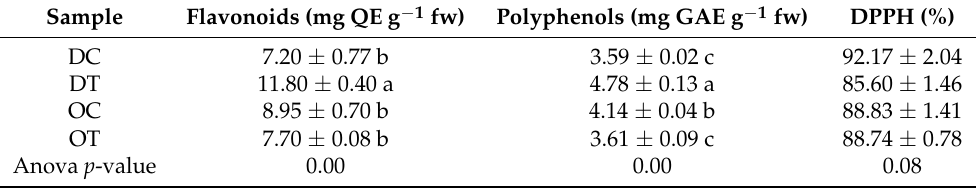
Table 8. The content of bioactive compounds (flavonoids and polyphenols) and the antioxidant activity of wheat grass